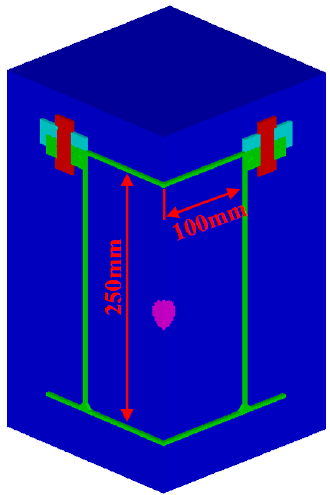
Figure 8. Numerical versus experimental results on the midpoint deflection–thickness ratio.